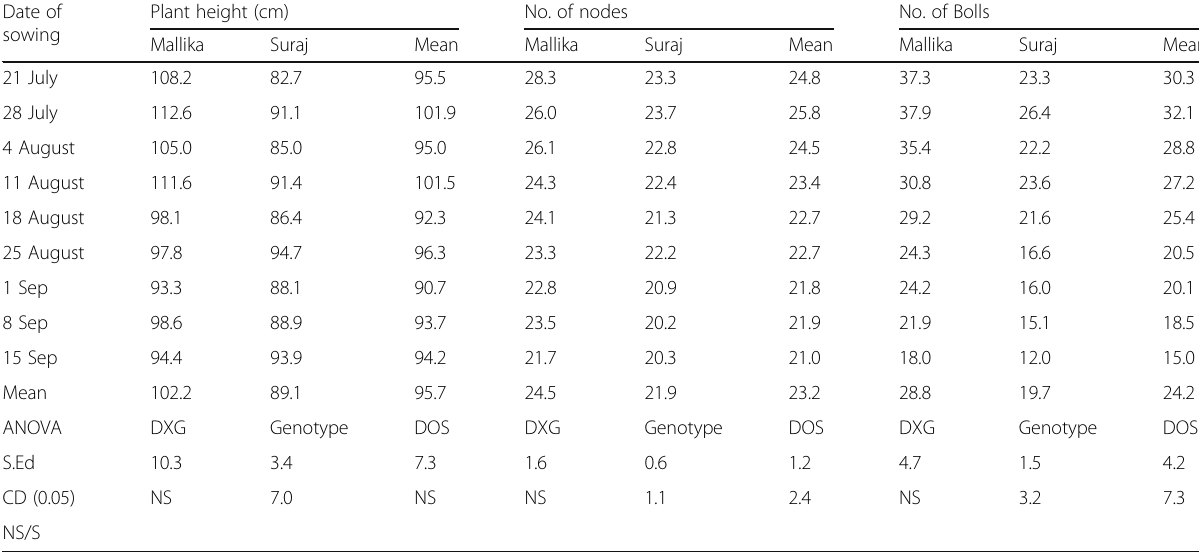
Table 2 Growth characters as influenced by genotypes and date of sowing at harvest Date of Plant height sowing